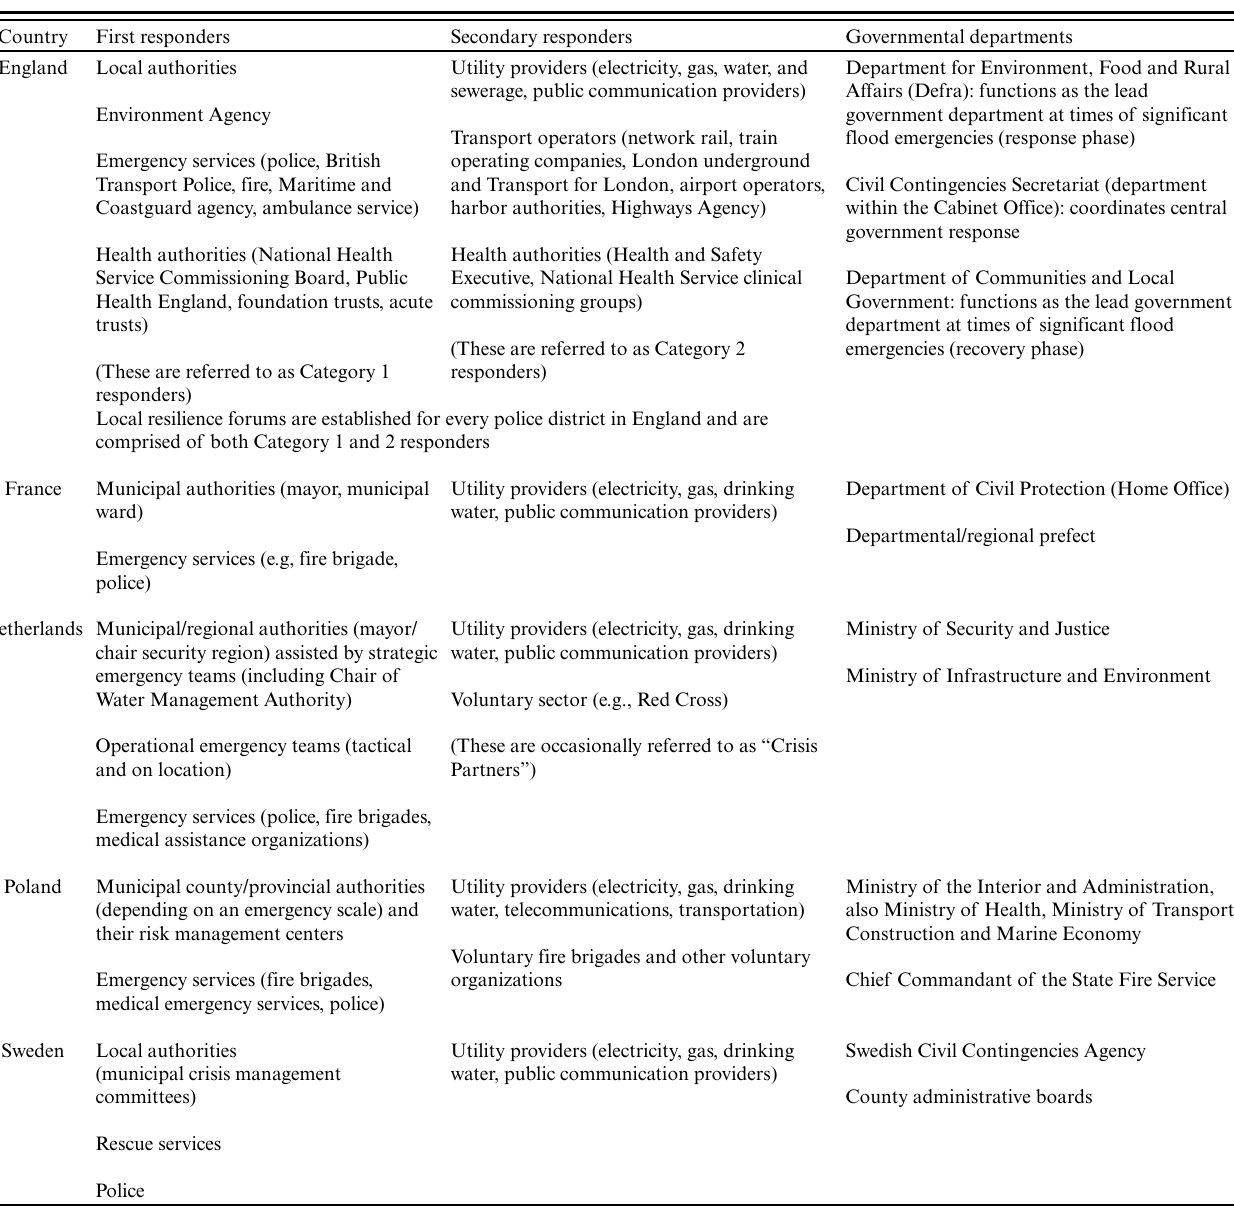
Table 2 . Summary of emergency actors in selected countries.